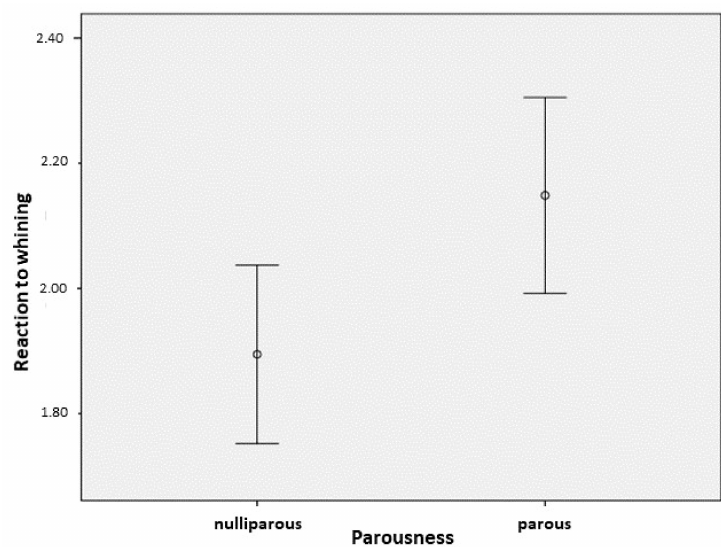
Figure 3. Adult (male + female) dogs’ reaction (mean ± 95% CI) to the whining of puppies in association with the parousness of the adults (0 = did not have puppies; 1 = had puppies before).